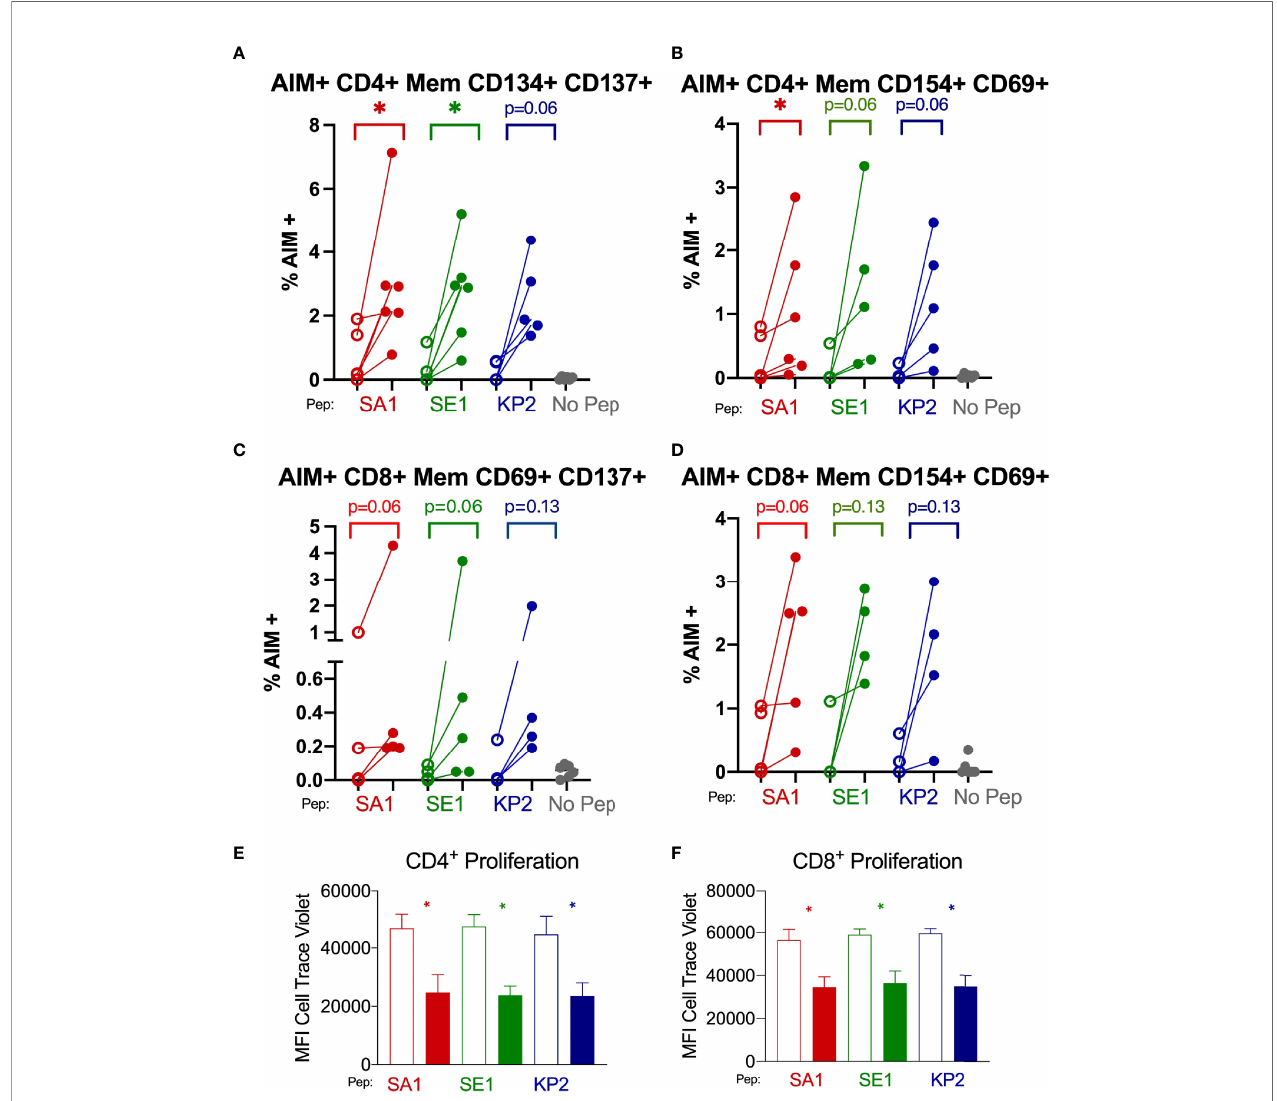
FIGURE 6 | SARS-CoV-2 vaccination enhances T memory cell reactivity to pathogenic bacterial homologues by AIM and proliferation markers Direct ex-vivo T memory (Mem) cell responses of donors (n=6) pre-SARS-CoV-2 vaccination (unshaded dots) and post-SARS-CoV-2 vaccination (shaded dots) to pathogenic bacterial peptides sharing homology with SARS-CoV-2 spike (SA1, SE1 and KP2) measured by activation-induced markers (AIM) signifying antigen-speci fi c responses (A – D) . 7-day proliferation assay of donors (n=6) pre-vaccination (unshaded bars) and post-vaccination (shaded bars) (E, F) . No Pep – no peptide negative control. MFI – mean fl uorescence intensity. *P<0.05 by Wilcoxon matched-pairs signed rank test. (A) AIM + CD4 + T memory cell responses measured by co- expression of CD134 and CD137 (n= 5-6). (B) AIM + CD4 + T memory responses measured by co-expression of CD154 and CD69 (n= 5-6). (C) AIM + CD8 + T memory cell responses measured by co-expression of CD69 and CD137 (n= 4-5). (D) AIM + CD8 + T memory cell responses measured by co-expression of CD154 and CD69 (n= 4-5). (E) CD4 + T cell proliferation in response to bacterial peptide homologues pre-and post SARS-CoV-2 vaccination (n= 6). (F) CD8 + T cell proliferation in response to bacterial peptide homologues pre-and post SARS-CoV-2 vaccination (n=